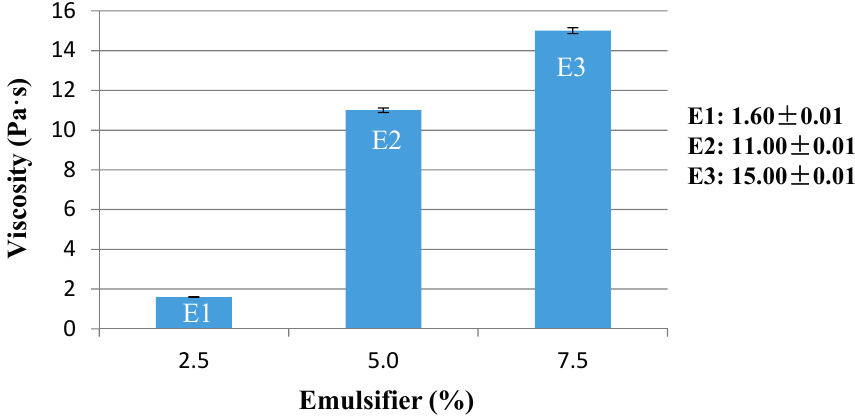
Figure 3. Viscosity of O/W basic emulsions (E1–E3) containing a different percentage of